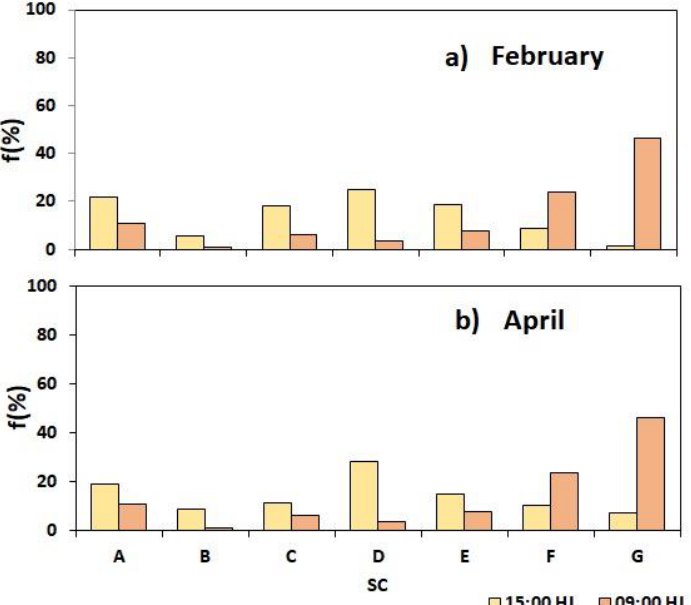
Figure 2. Relative frequency (f [%]) of atmospheric stability (SC, [36]) in Neuquén as a function of the month (( a ) February , ( b ) April) at 09:00 LT (light yellow) and at 15:00 LT (dark yellow), for the period 2015 – 2021. Classes: A: extremely unstable; B: moderately unstable; C: lightly unstable; D: neutral; E: lightly stable; F: moderately stable, G: extremely stable. Data from the Real-time Envi- ronmental Applications and Display sYstem (READY, http://www.ready.noaa.gov (accessed on 10 th May 2022)).